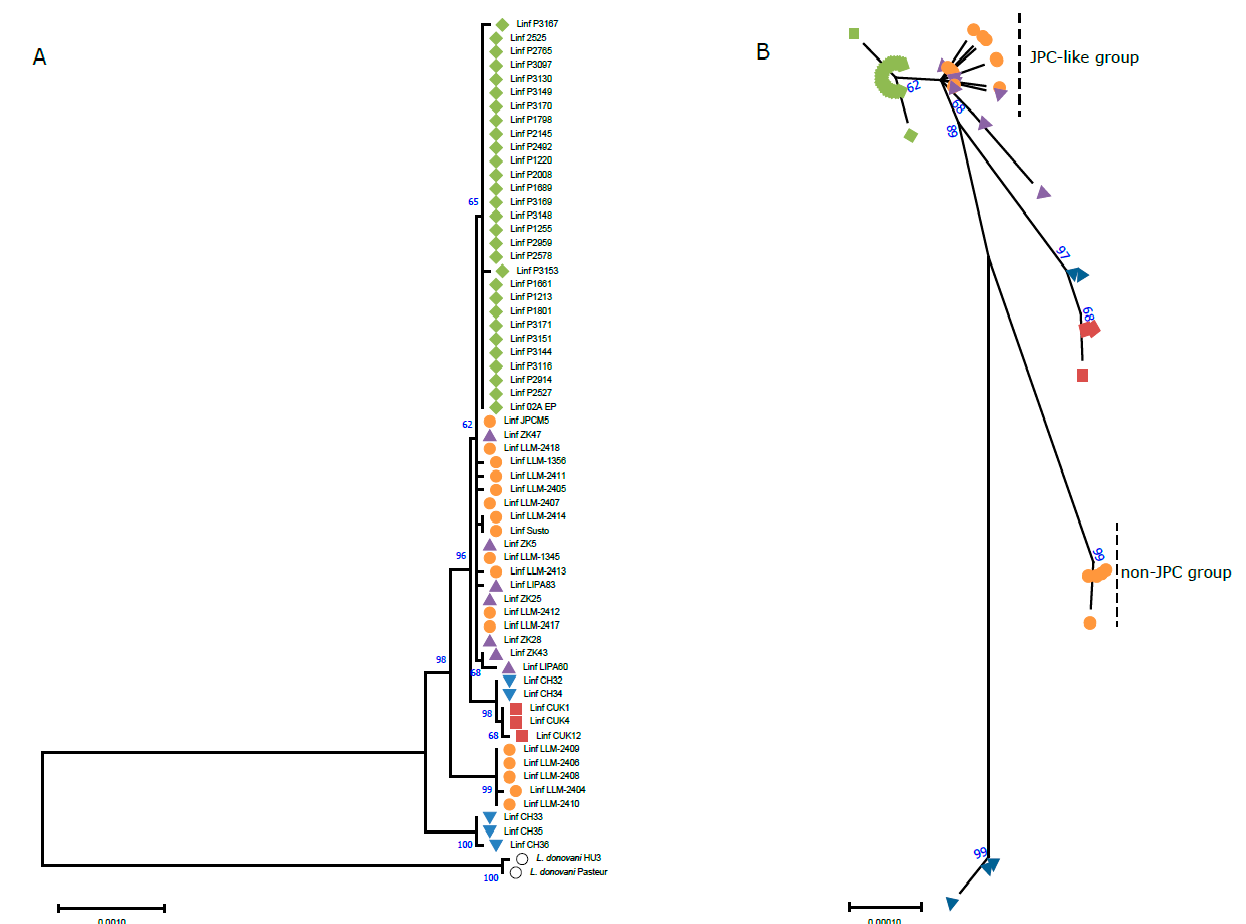
Figure 3. Phylogenic relationship among Mediterranean and American L. infantum isolates ( A , B ). The evolutionary history was inferred using the maximum likelihood method and the Tamura–Nei model [43]. The tree with the highest log likelihood ( − 21,148.45) is shown. The tree is drawn to scale, with branch lengths representing the number of substitutions per site. This analysis involved 63 nucleotide sequences. Codon positions included were 1st + 2nd + 3rd + Noncoding. There was a total of 16,285 positions in the final dataset. Brazilian isolates; Spanish isolates; Tunisian iso- lates; Turkish isolates; Cypriot